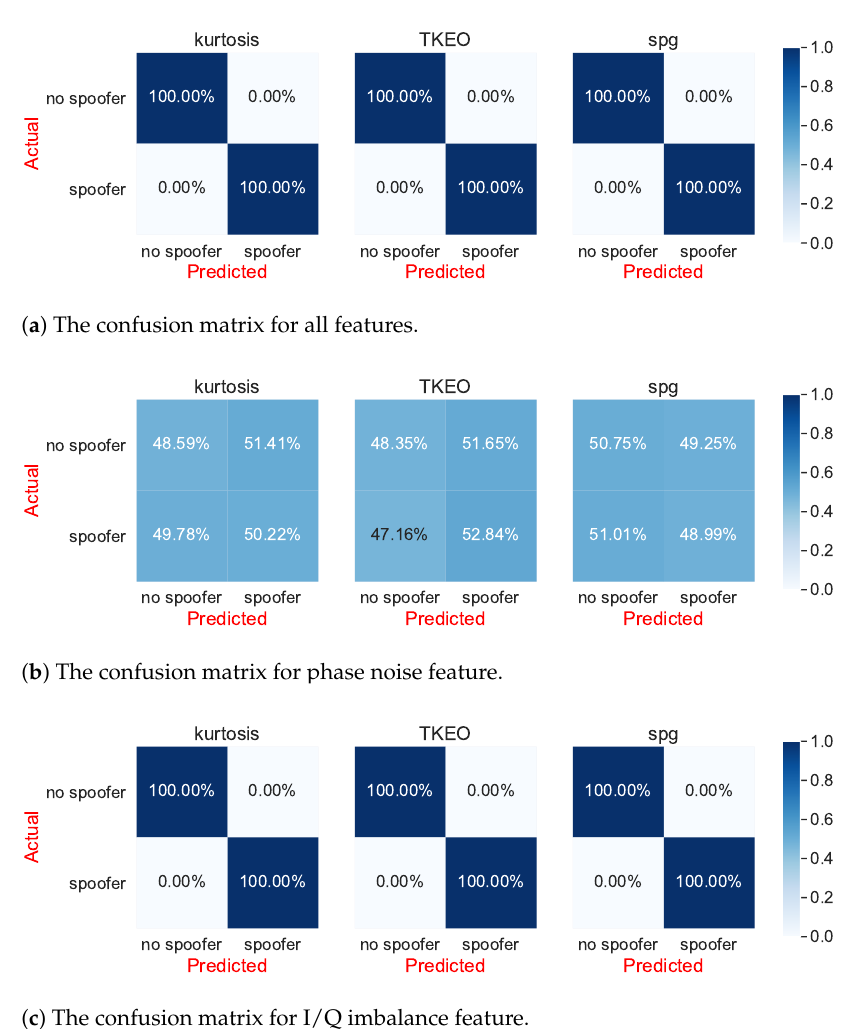
Figure 20. Count